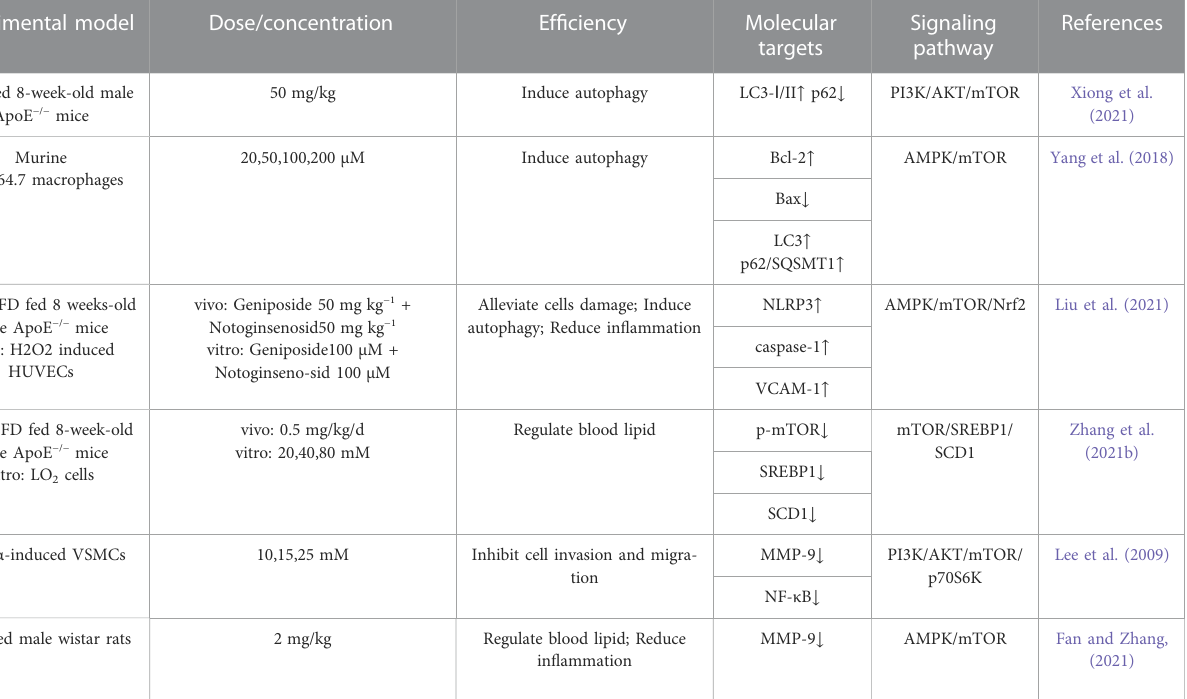
TABLE 3 Summary of the effects of natural compounds of glycosides on different AS models. Active